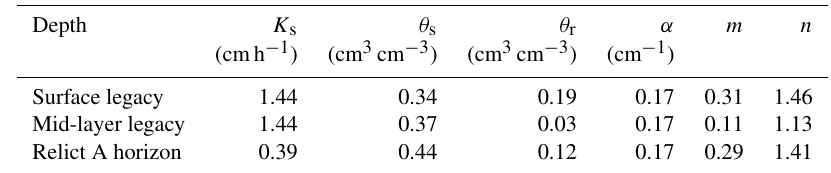
Table 2. Soil hydraulic parameters ∗ derived from soil water retention curves fitted to the van Genuchten soil hydraulic model (van Genuchten, 1980) using the SWRC Fit program (Seki, 2007) for each soil depth (surface legacy sediment, mid-layer legacy sediment, and relict A horizon soil).